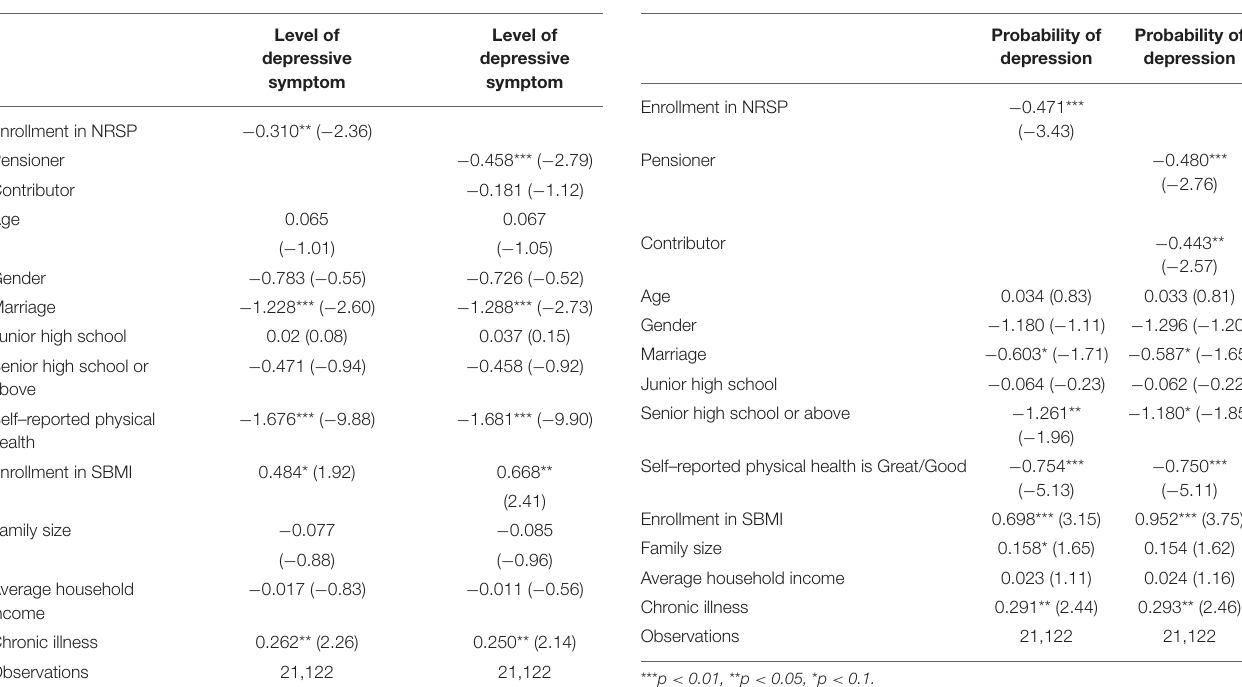
TABLE 2 | Regression results of equation (1). TABLE 3 | Results of logit